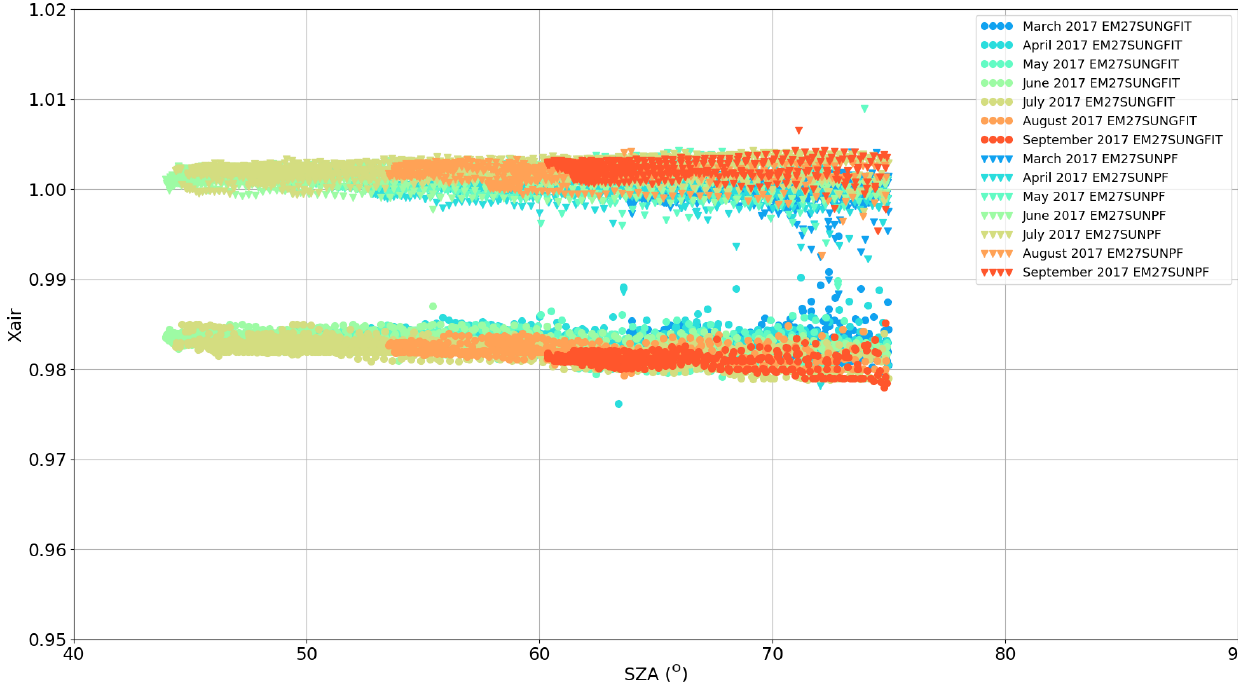
Figure 14. Xair plotted with respect to the measurement solar zenith angle for retrievals performed with EM27/SUN data following COC- CON recommendations (EM27SUNPF) and using GFIT (EM27SUNGFIT) for measurements performed at Sodankylä in